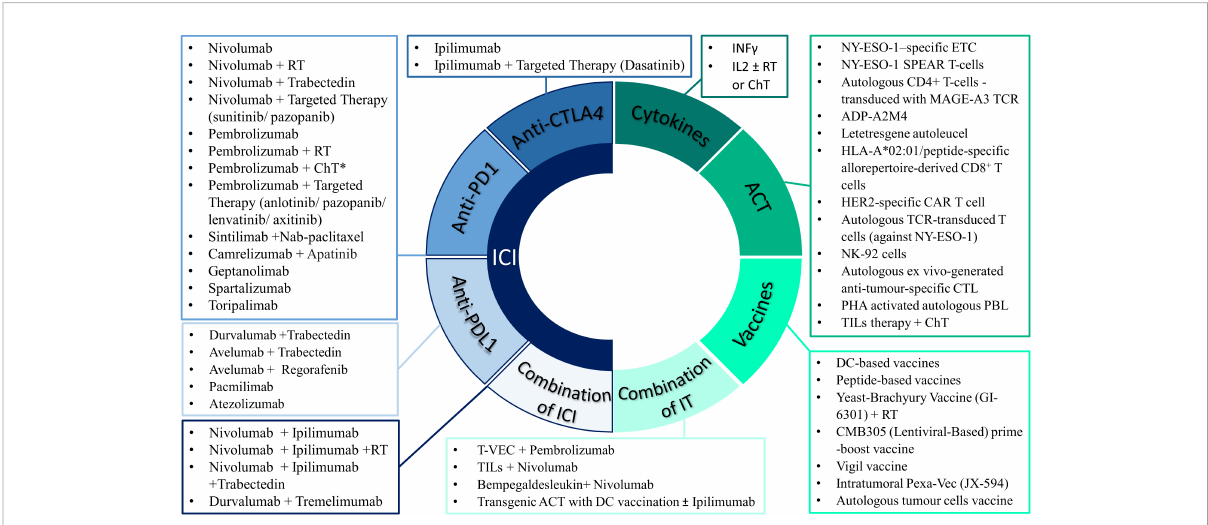
FIGURE 1 Selected approved and experimental immunotherapy drugs that have been used as single agent or in combination with other treatment modalities in patients with sarcomas. *ChT includes the following regimens: Doxorubicin, AIM (anthracycline, ifosfamide, mesna), AD (anthracycline, dacarbazine), High-dose ifosfamide, Gemcitabine ± Docetaxel or Dacarbazine or Nab-paclitaxel or Vinorelbine, Irinotecan, Liposomal doxorubicin, Metronomic cyclophosphamide. IT, immunotherapy approaches; ICI, immune checkpoint inhibitors; CTLA4, cytotoxic T lymphocyte-associated molecule 4; PD1 programmed death 1; PDL1, programmed death-ligand 1; ACT, adoptive cell therapy; ETC, endogenous T cells; CTL, cytotoxic T lymphocytes; TCR, T-cell receptor; CAR, Chimeric Antigen Receptor; TILs, tumour-in fi ltrating lymphocytes; NK,